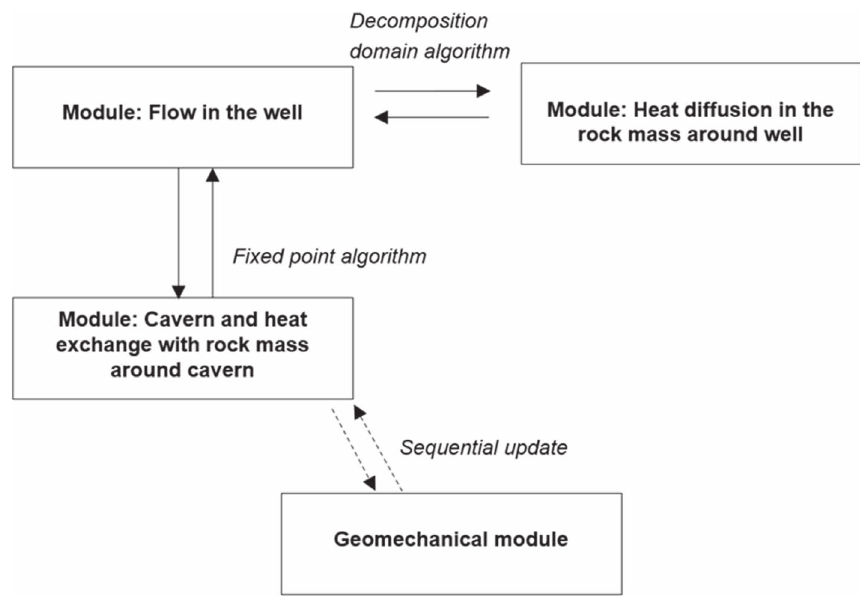
Fig. 3. Different coupling and modules used in the